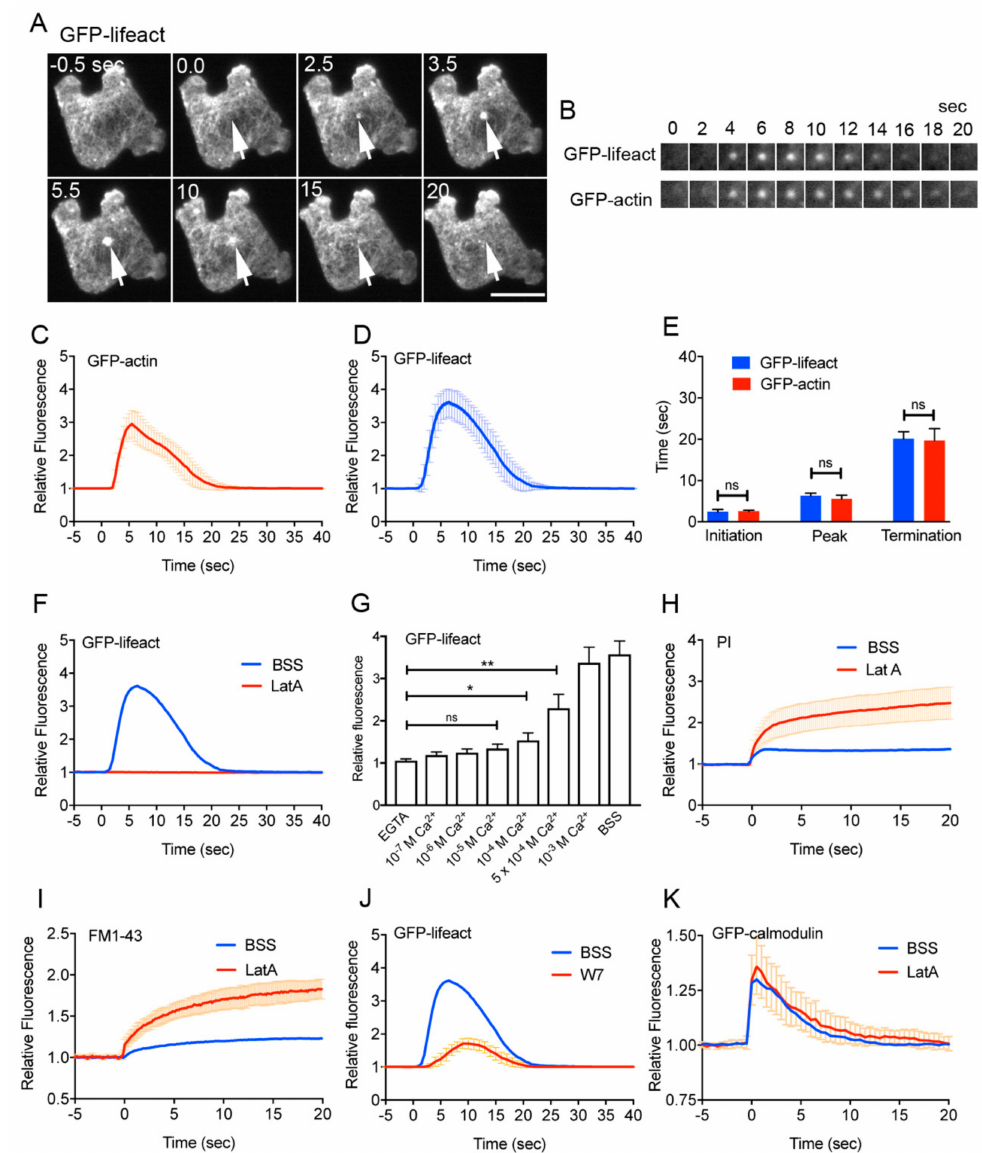
Figure 3. Actin accumulation is essential for wound repair. ( A ) A typical sequence of fluorescence images of a cell expressing GFP-lifeact, as a marker of actin filaments. Arrows indicate the position of wound site. Bar, 10 µ m. ( B ) Typical sequences of fluorescence images at the wound sites of cells expressing GFP-lifeact and GFP-actin, respectively. ( C ) Time course of relative fluorescence intensity of GFP-actin at wound site. ( D ) Time course of relative fluorescence intensity of GFP-lifeact at wound site. ( E ) Comparison of initiation time, peak time, and termination time between GFP-lifeact and GFP-actin. ( F ) Time courses of relative fluorescence intensity of GFP-lifeact in the presence and absence of latrunculin A. ( G ) A dependency of the accumulation of GFP-lifeact at the wound site on free Ca 2 + concentration in the external medium. The peak intensities of GFP-lifeact were plotted versus each free Ca 2 + concentration. Data are presented as mean ± SD (n = 25, each). * p ≤ 0.001; ** p ≤ 0.0001; ns, not significant, p > 0.05. ( H ) Time courses of PI influx in the presence and absence of latrunculin A, a depolymerizer of actin filaments. ( I ) Time courses of FM1-43 influx in the presence and absence of latrunculin A. ( J ) Time courses of relative fluorescence intensity of GFP-lifeact in the presence and absence of W7. ( K ) Time courses of relative fluorescence intensity of GFP-calmodulin in the presence and absence of latrunculin A. All graphs are shown with average ± SD (n = 25,